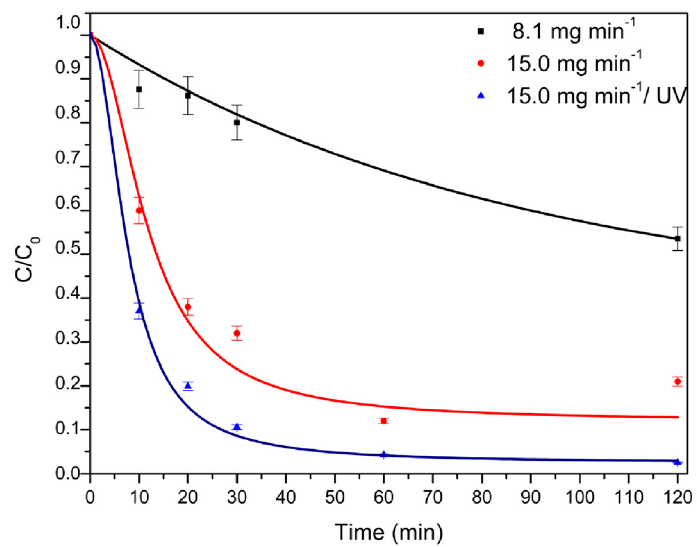
Figure 7. Experiments on AMX degradation (C/C 0 ) by ozone-based advanced oxidation processes. Experiments carried out at pH 11.00 and temperature control at (20.0 ± 0.5) °C. Feed ozone mass–rate: 8.13 mg min − 1 and 15.00 mg min − 1 .